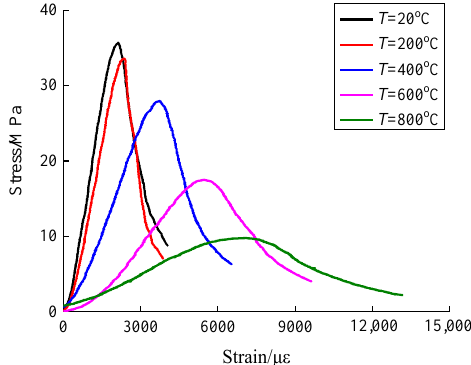
Figure 5. Stress-strain curve of concrete under static conditions.